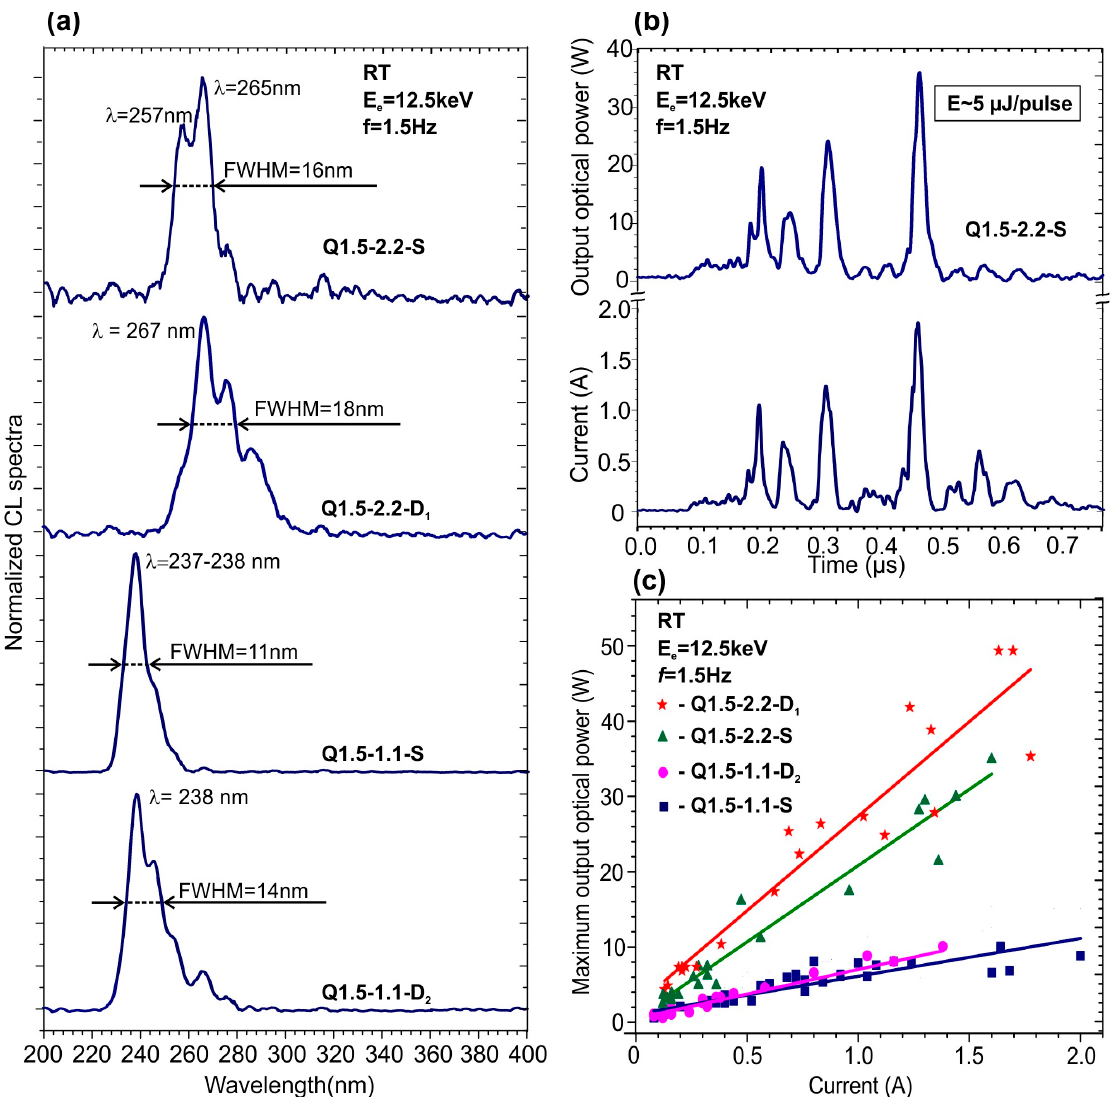
Figure 10. ( a ) Normalized CL spectra at RT excited with a “high-current” pulse e-gun at the same E e = 12.5 keV, which were measured in 400 × {GaN 1.5 /AlN 16 } MQW structures grown under various Ga/N 2 * flux ratios on different AlN templates. ( b ) The output optical power (upper, blue) from structure Q1.5-2.2-S excited by the e-beam current supplied by a “high-current” pulse e-gun at E e =12.5 keV, the time changes of which are shown in the lower violet curve. ( c ) Dependences of the output optical power on the current of an e-beam with an energy of 12.5 keV, measured for different 400 × {GaN 1.5 /AlN 16 } MQW structures. The lines are drawn in accordance with the linear interpolation of the experimental data.